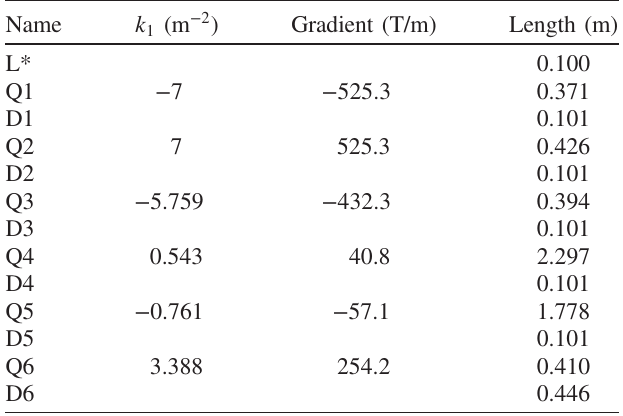
TABLE III. Quadrupoles Q1 to Q6 k 1 component, equivalent gradient for a 22.5 GeV muon beam, length and drifts D1 to D6. This list corresponds to half of the lattice, the second half is an antisymmetric reflection, drifts are equal and magnet polarity is